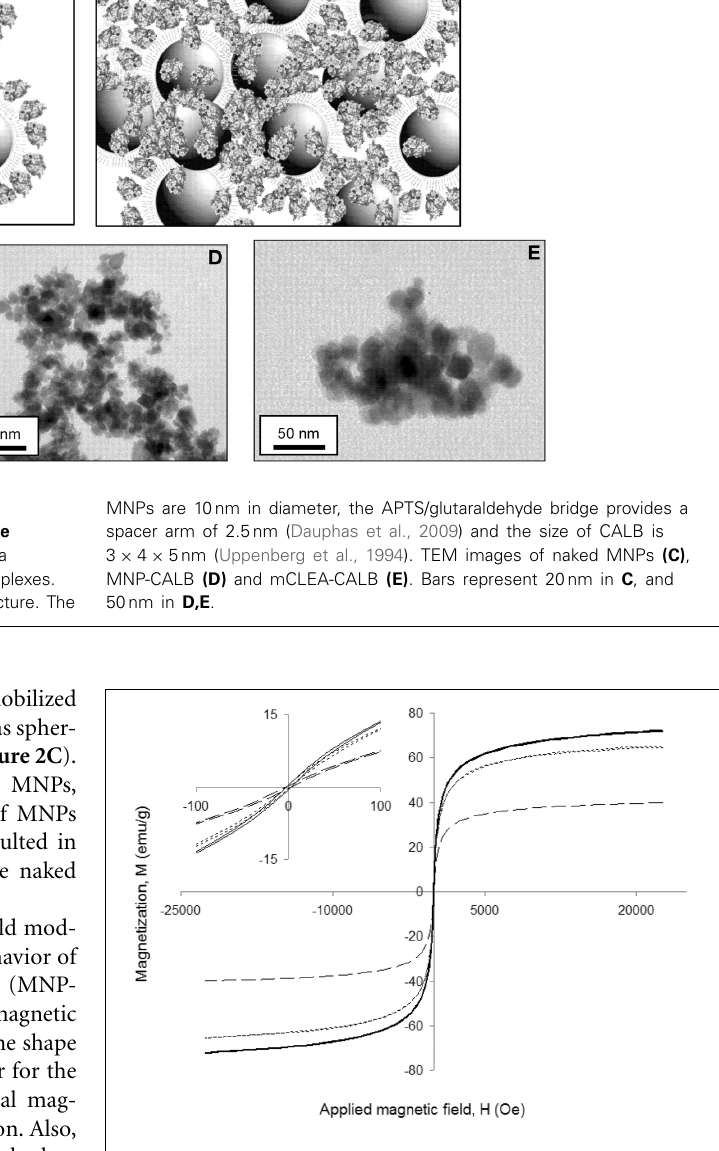
FIGURE 3 | Magnetization analysis at 300K of the magnetic biocatalysts obtained with CALB. MNP-CALB (solid lines), mCLEA-CALB with 25 μ g protein/mg MNPs (dotted lines with short strokes) and mCLEA-CALB with 100 μ g protein/mg MNPs (dotted lines with long strokes). Inlet shows a detail of magnetization for values of magnetic field near to